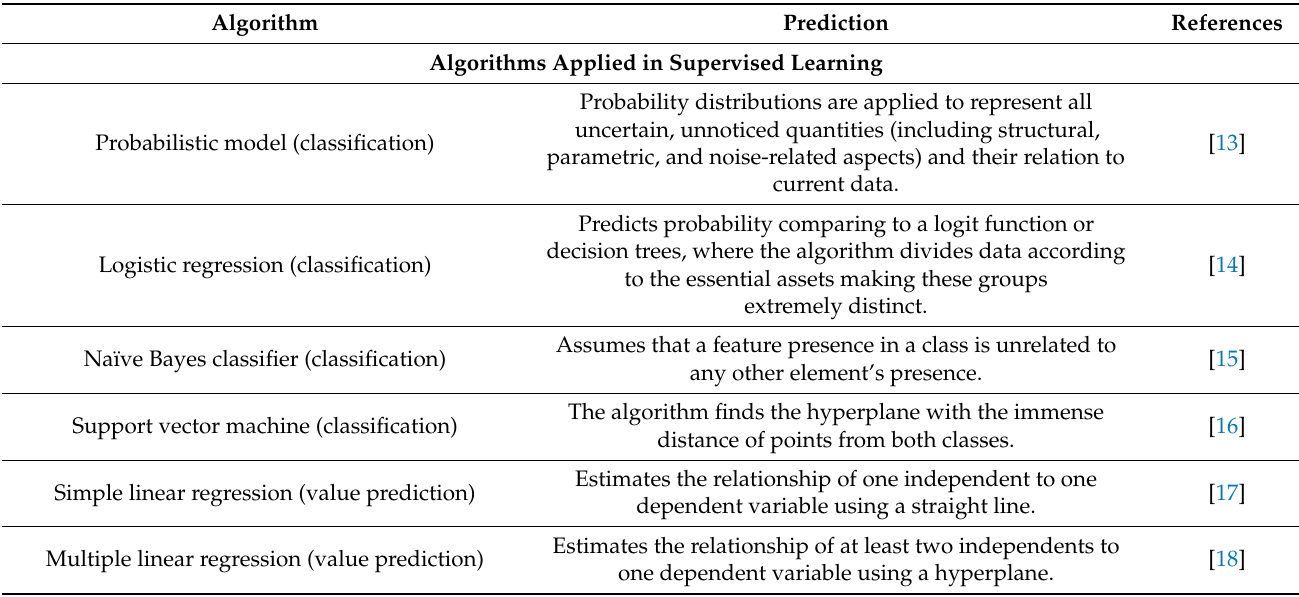
Figure 1. Machine learning models and algorithms. Machine learning is a subfield of artificial intelligence science that enables the machine to become more effective with training experience. Three principal learning models are supervised learning, unsupervised learning, and reinforcement learning. Learning models differ depending on the input data type and require various algorithms. Table 2. Examples of specific algorithms suited for different learning models. Algorithm